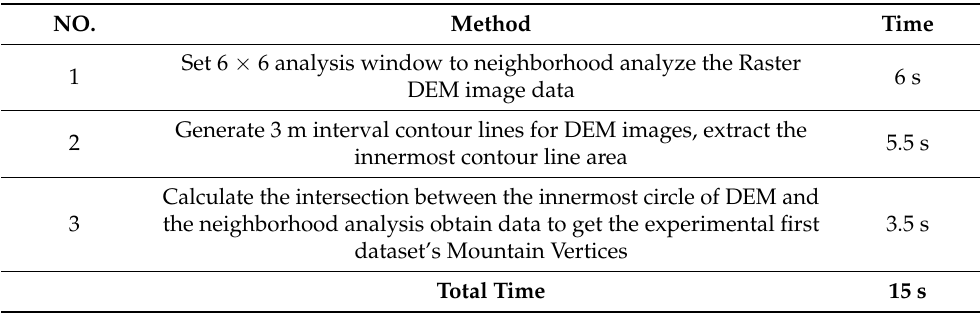
Table 6. The time spent in extracting mountain vertices for the first dataset using the Contour Line and Neighborhood Analysis Overlay